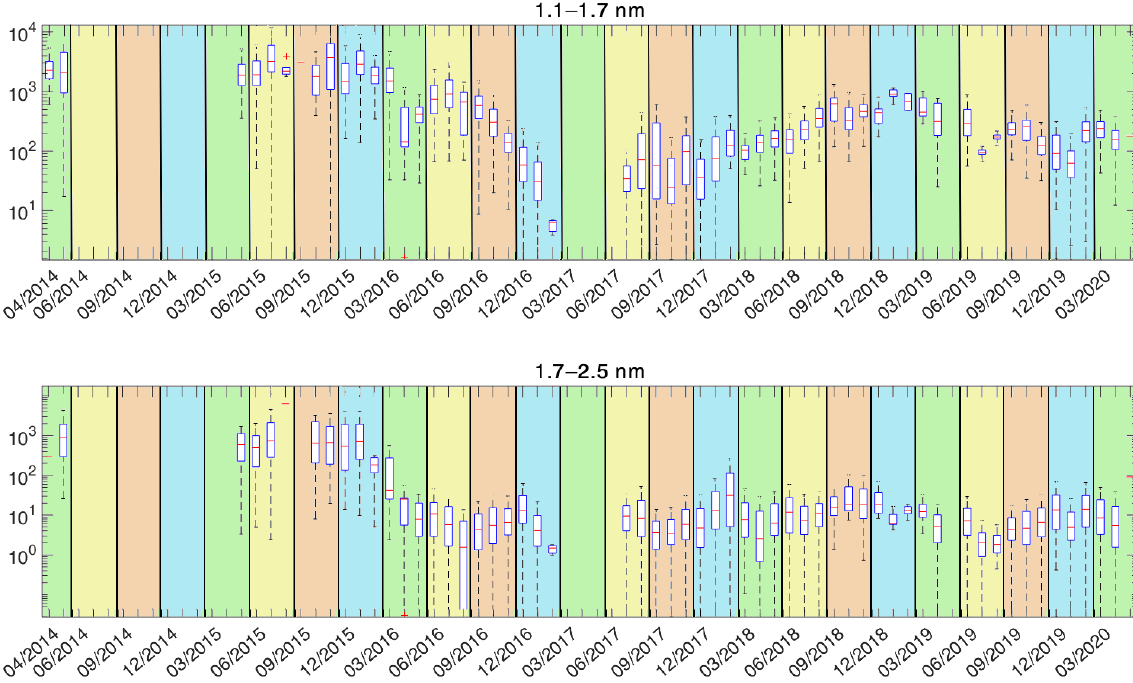
Figure 4. The monthly variation of the particle concentration in the two PSM size bins. The red line shows the median concentration for each month and the blue box contains 50% (25th to 75th percentile) of all data points. The whiskers mark the location of the 95th and 5th percentile data points. The areas with the green background are spring months, the yellow background represents summer months, the brown background represents autumn months, and the blue background represents winter months. The tick marks visible are in the middle of each month.